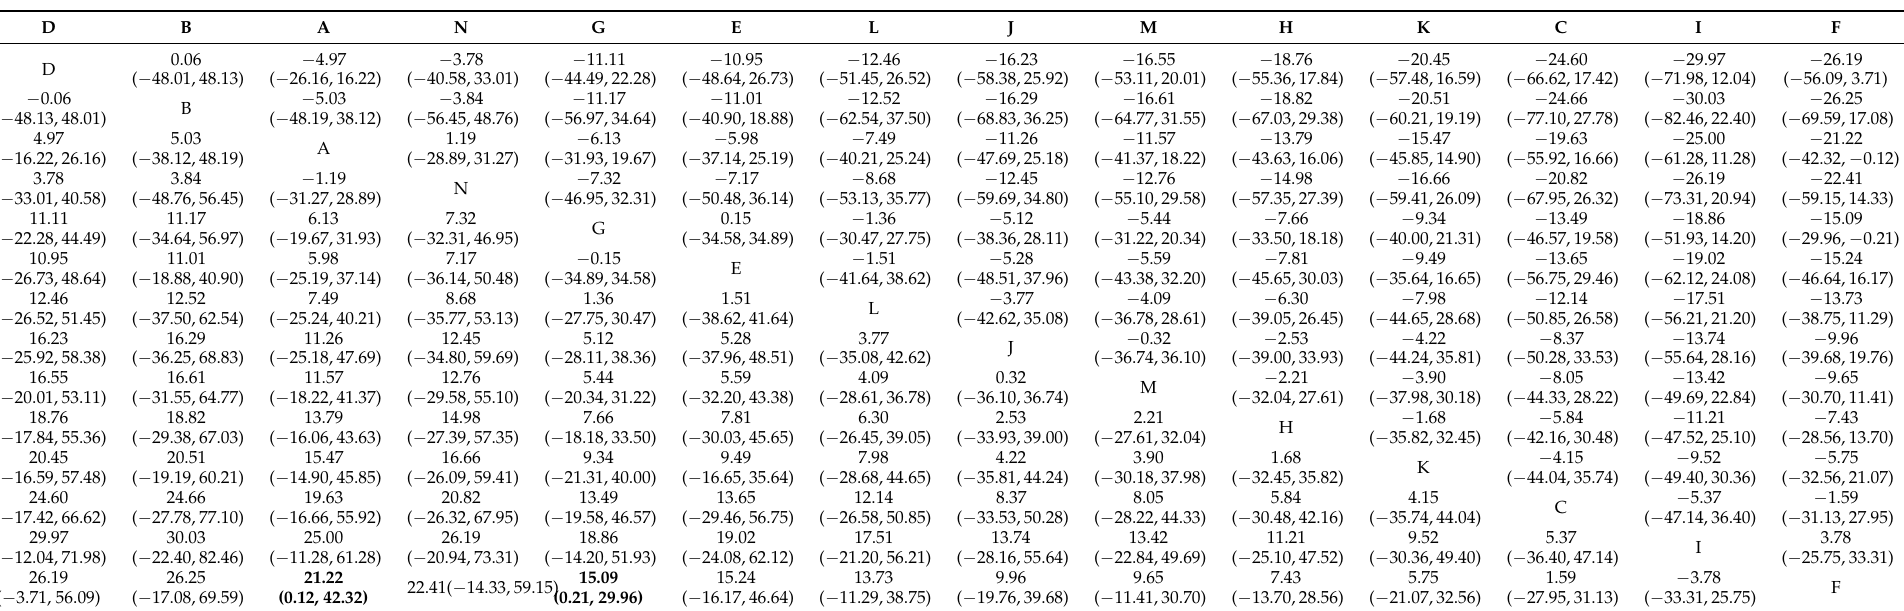
Table 3. Network analysis results of the comprehensive